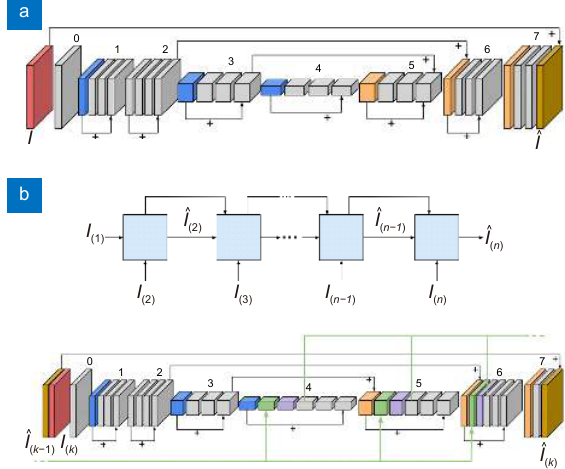
Fig. 16 | ( a ) Architecture of the encoder-decoder deconvolution neur- al network. The details of the architecture are described in Ref. 95 . ( b ) Upper panel: end-to-end deconvolution process, where the grey blocks are the deconvolution blocks described in the lower panel. Lower panel: internal architecture of each deconvolution block. Col- ors for the blocks and the specific details for each block are de- scribed in the reference. Figure reproduced from: (a, b) Ref. 95 ,